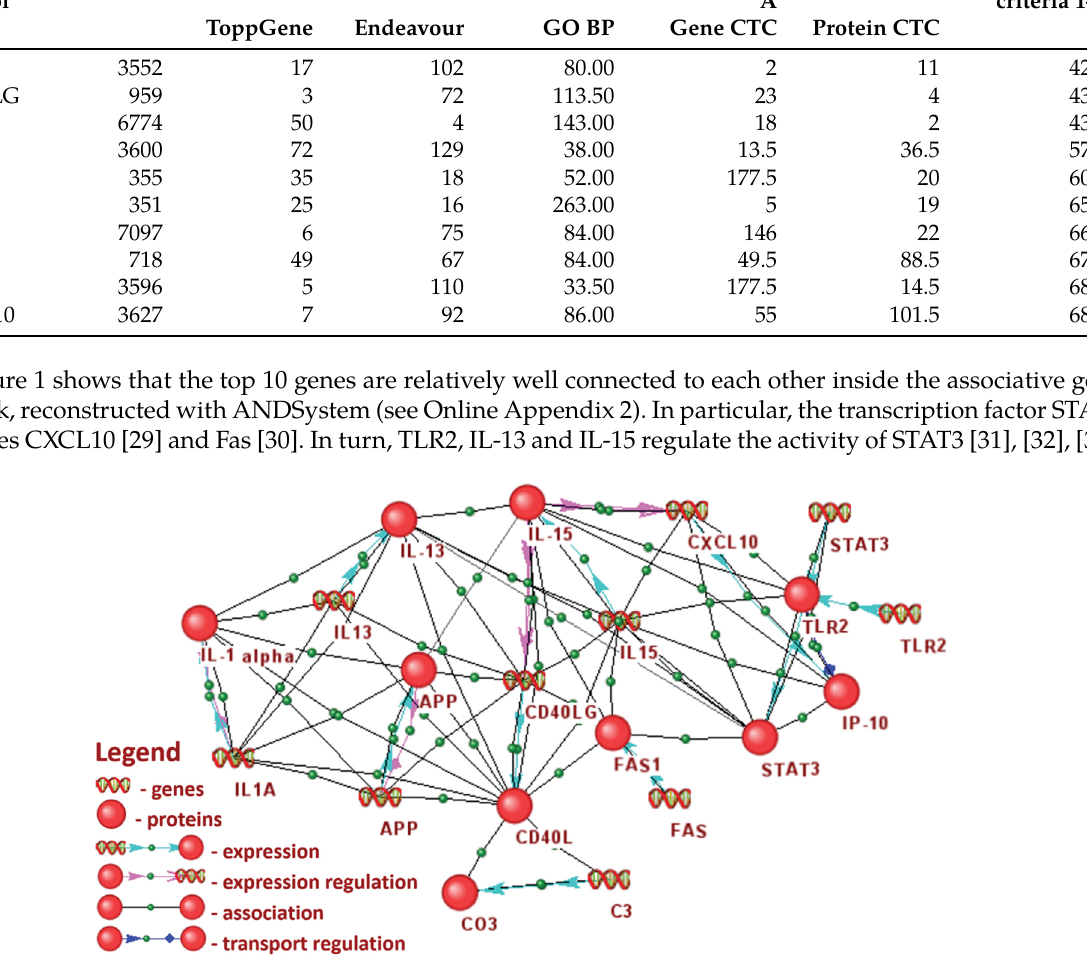
Figure 1: An associative gene network reconstructed with ANDSystem, illustrating the interactions of the top 10 of most significant